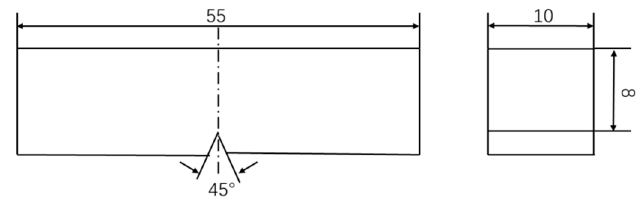
Figure 3. Dimensions of Charpy specimens in mm.